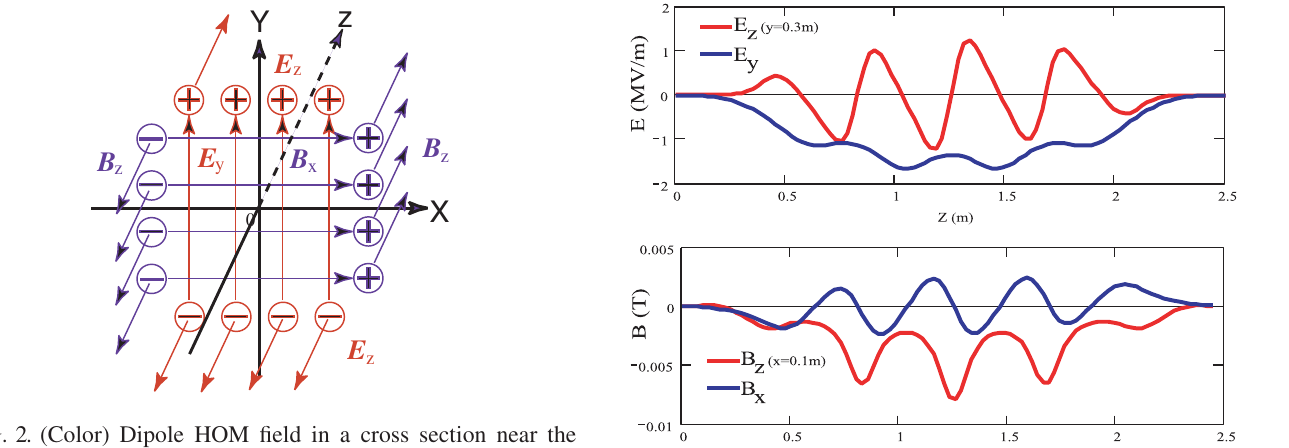
FIG. 2. (Color) Dipole HOM field in a cross section near the cavity axis.